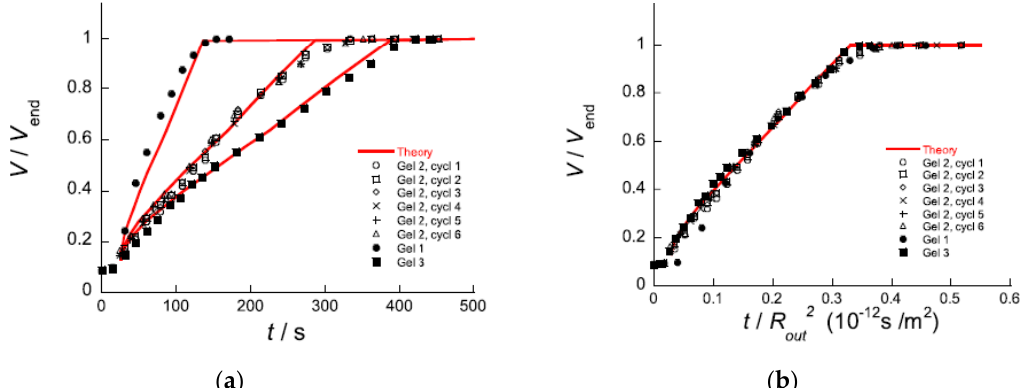
Figure 26. ( a ) Relative microgel volume as a function of time during release of amitriptyline hydrochloride (AMT) for three different microgels of different sizes. Release medium is 150 mM NaCl. V is the actual microgel volume, and V end is the volume after completed release; ( b ) master curve obtained from ( a ) by normalizing time by the square of radius of the respective network in the reference state (R out ), as suggested by theory. Figure adapted from ref. [69]. Used with permission.